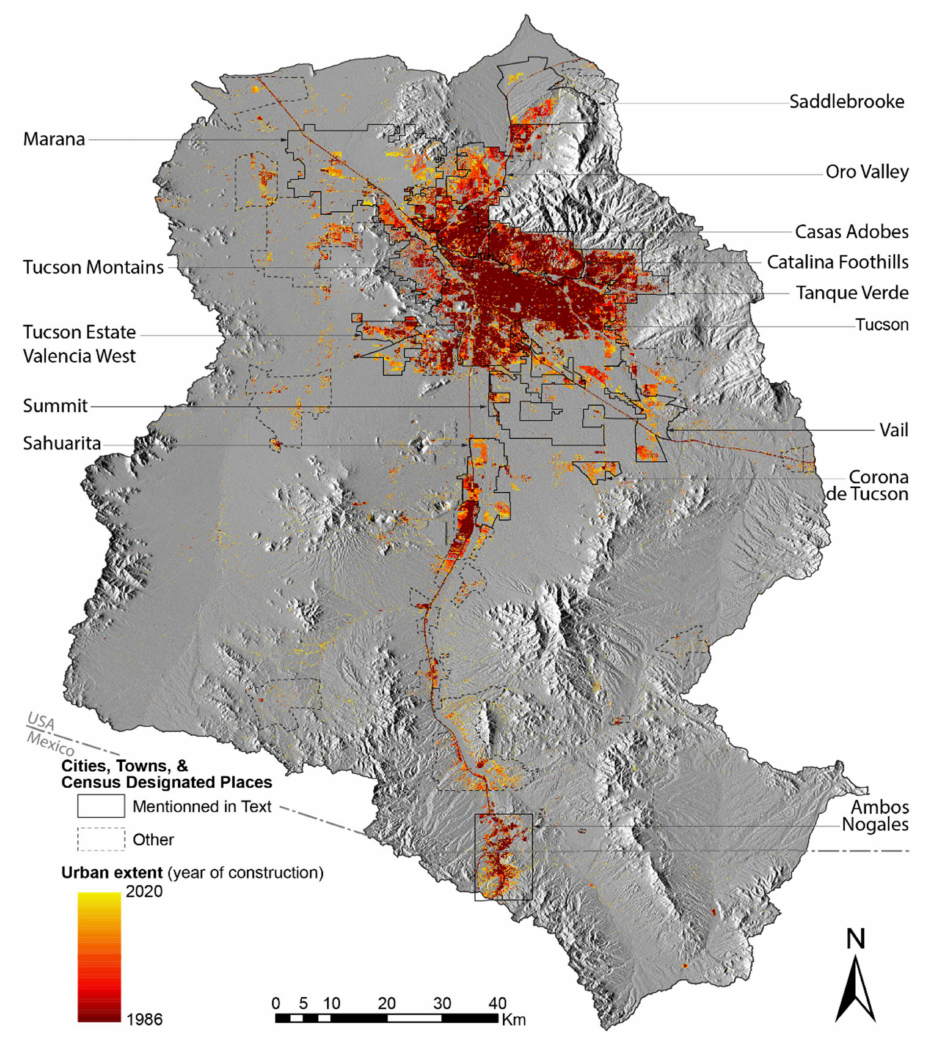
Figure 8. Urban extension in the upper Santa Cruz watershed from 1986 to 2020. Hillshade derived from [43], census designated places from [84] and United States–Mexico border from